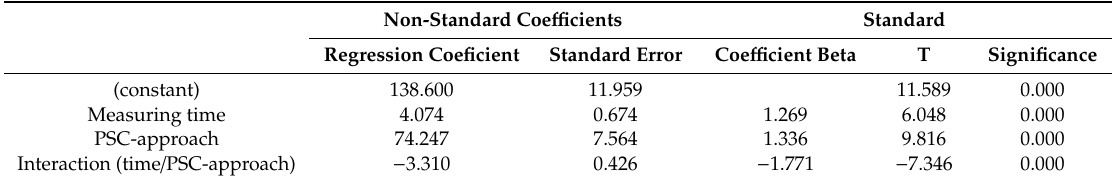
Table 5. Linear regression to determine the interaction e ff ect between PSC-approach and